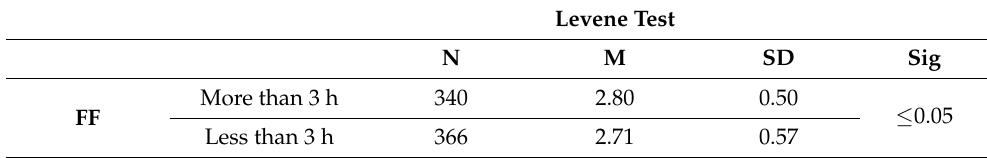
Table 2. Comparative study between time spent in physical activity and family functioning. Levene Test More than 3 h FF N M